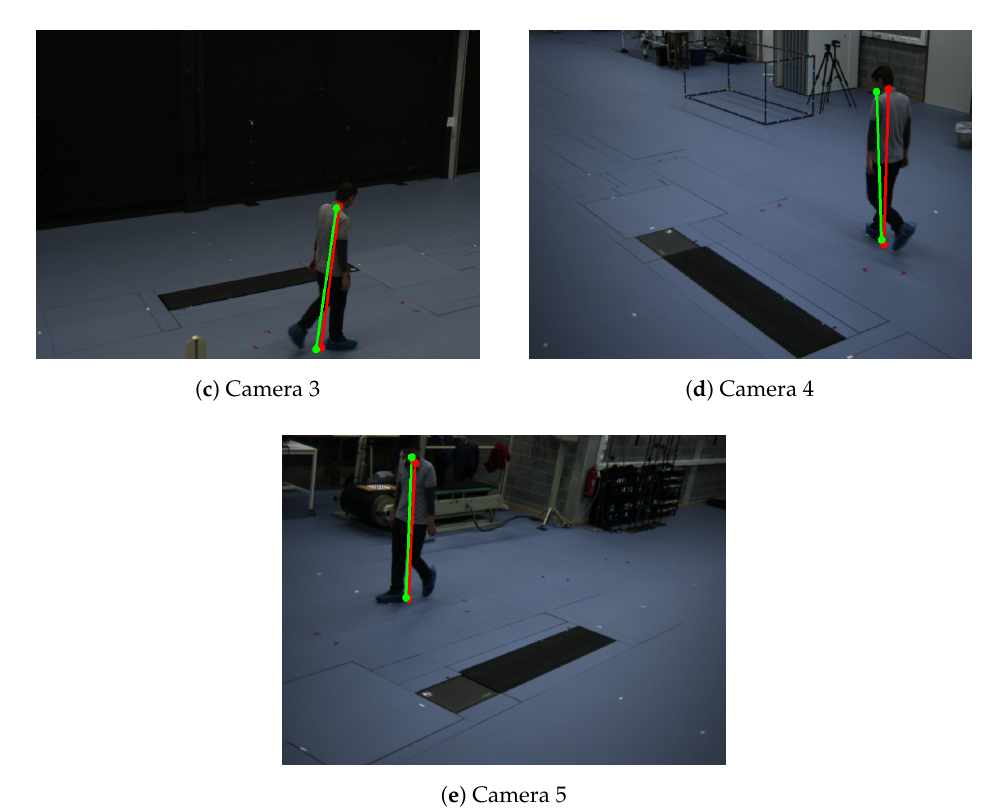
Figure 7. Example of detected the bottom and top positions of the pedestrians of Camera Network 4—single person in an empty room. Red color represents detected positions by the human pose estimation method. Green color represents the detected reprojected positions.